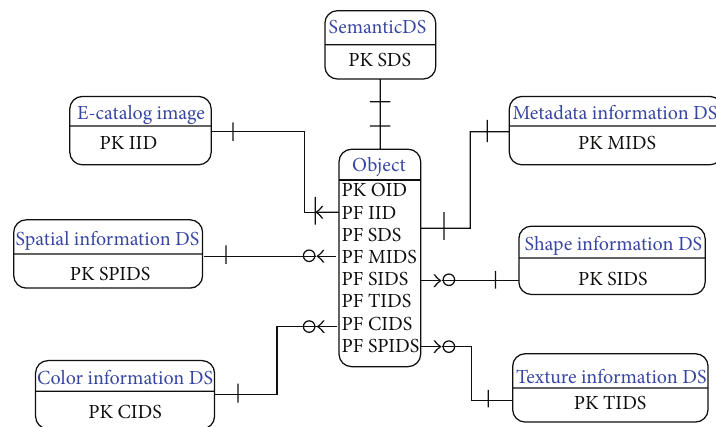
Figure 3: Image metadata schema in E-R diagram.